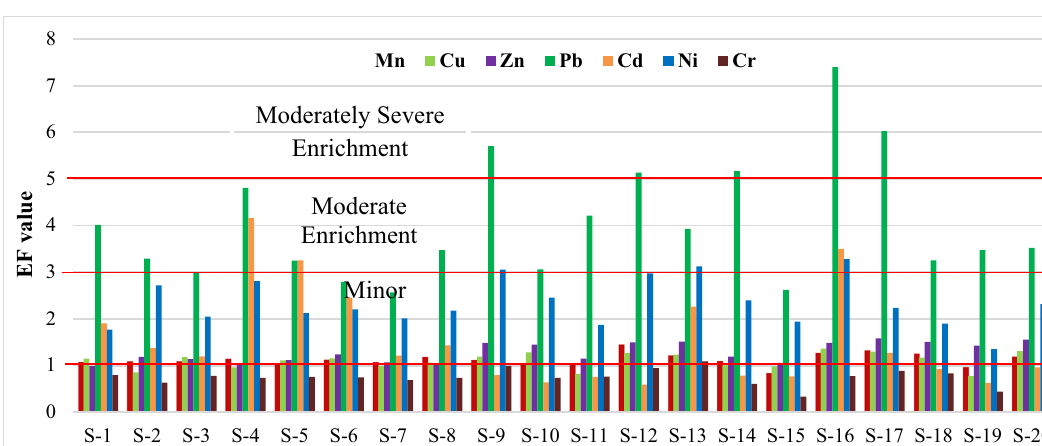
Figure 6. Enrichment of seven trace metals in the Sundarbans